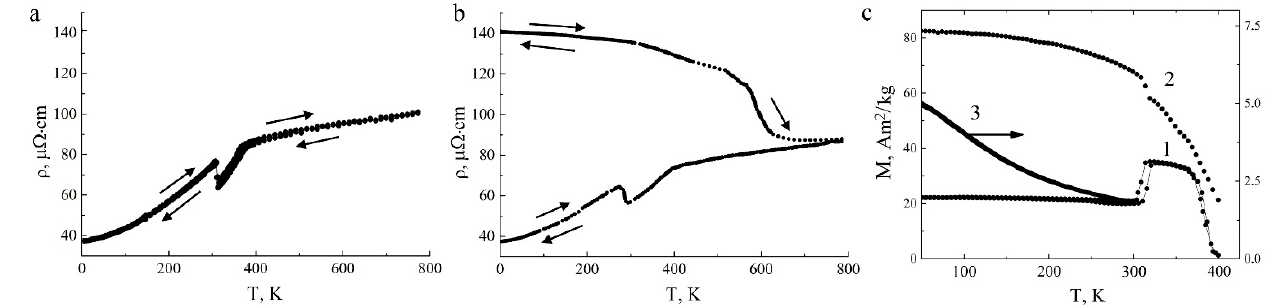
Figure 8. ( a , b ) Temperature dependences of electrical resistivity ρ ( T ) and ( c ) magnetization M ( T ) of Ni 50 Mn 28.5 Ga 21.5 alloy in the initial cast state or ( c ) after HPT at five revolutions and 5 GPa ( curves 1 at 0.8 MA/m, 2 and 3 at 4 MA/m). Curve 3, right ordinate axis.